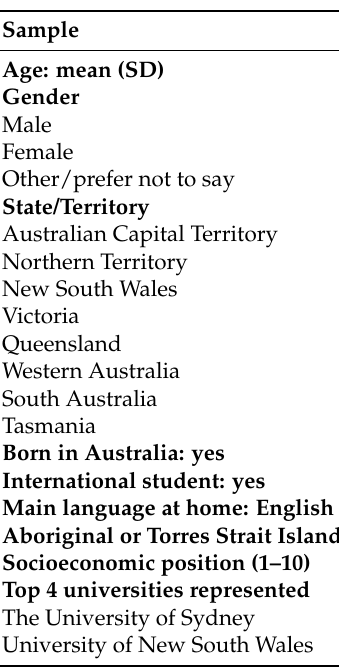
Table 2. Sample characteristics (N =